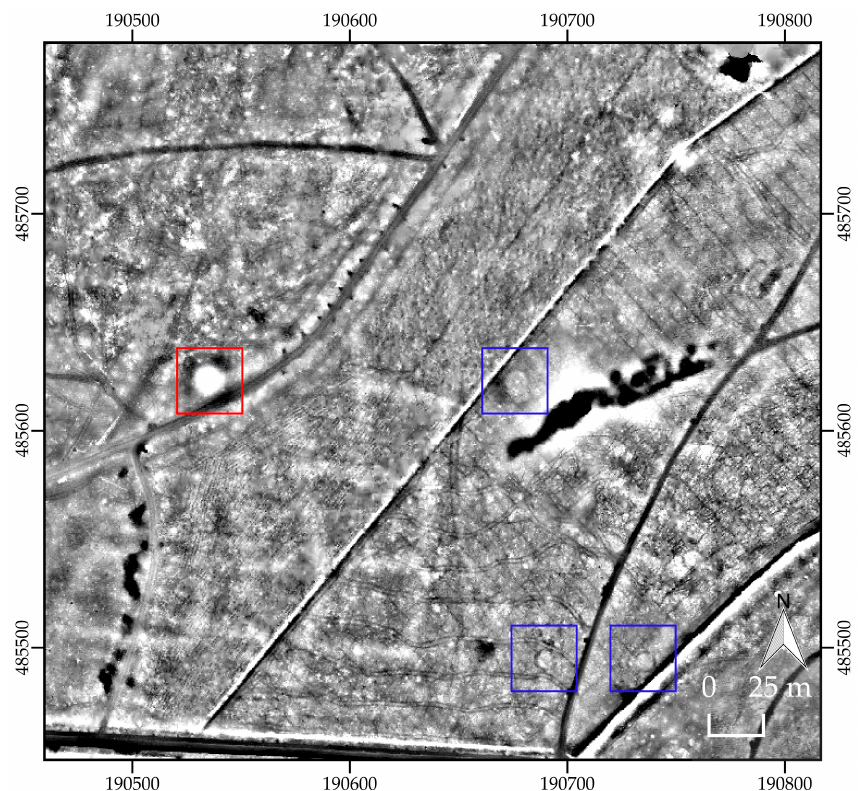
Figure 4. Sample of LiDAR data (source: Reference [63]; coordinates in Amersfoort/RD New, EPSG: 28992), visualized with Simple Local Relief Model, from the research area, showing a potential new barrow (red) and charcoal kilns (blue) amidst a Celtic field (white checkerboard pattern).